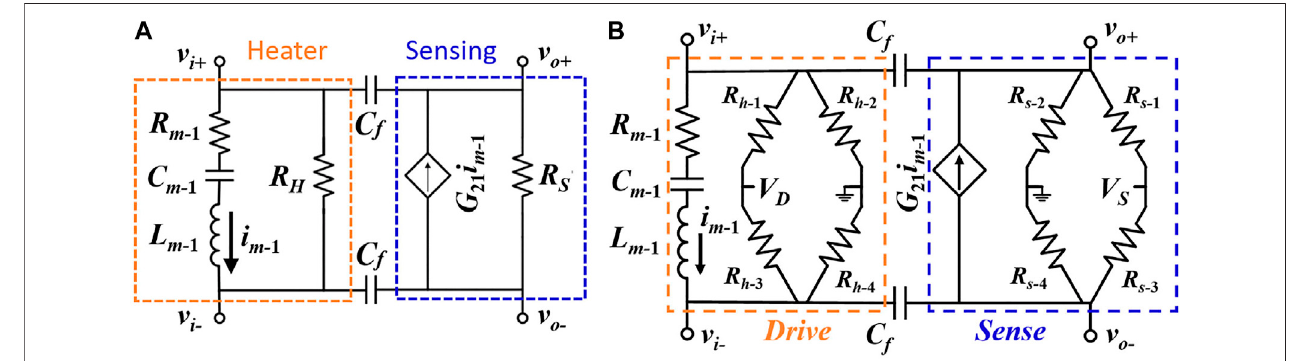
FIGURE 4 | Electrical equivalent circuit model for (A) II-bar and (B) balanced drive and sense CCB.